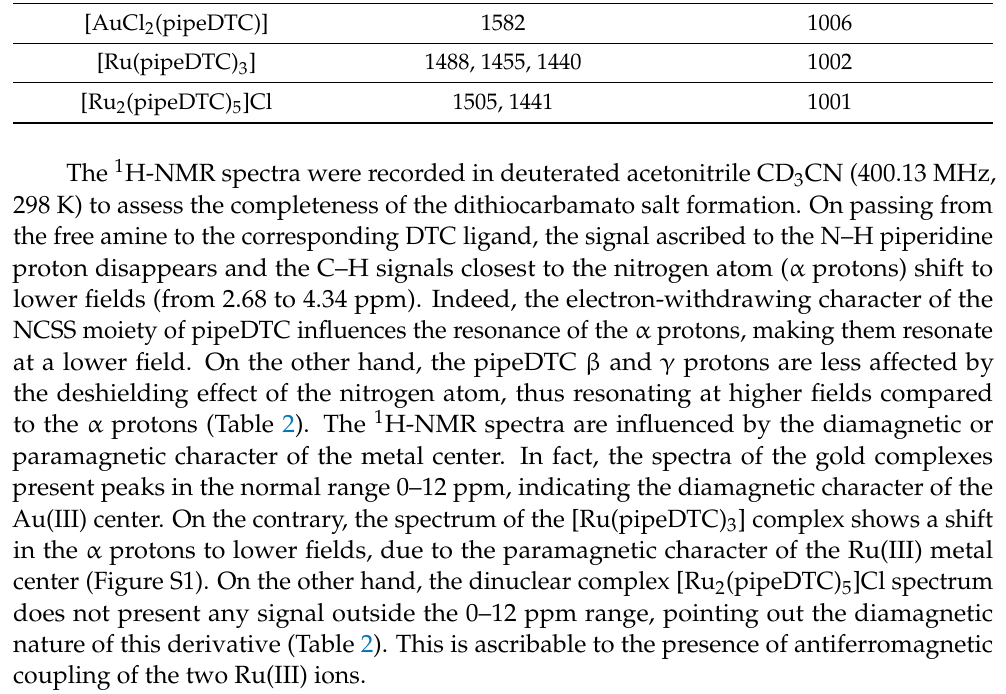
Table 2. List of the proton chemical shifts (ppm) of the N–H piperidine, and the DTC derivatives. α -CH 2 Compound